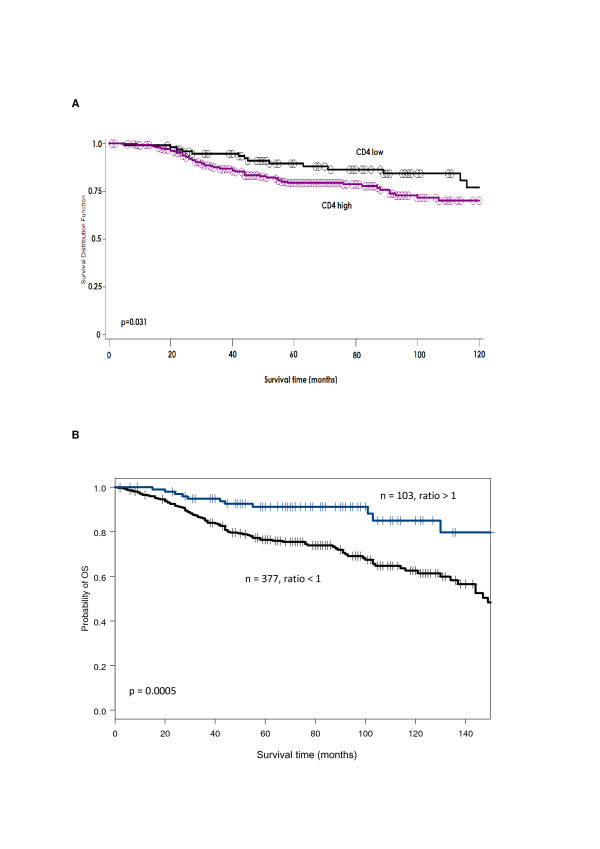
Overall survival analysis in patients with ductal breast cancer. A: Overall survival in patients with ductal carcinomas and high and low level of CD4+ TILs. Kaplan-Meier survival curves (univariate-analysis) of ductal breast cancers and overall survival in patients with high level of CD4+ versus low level of CD4+ cells infiltrating the tumor. CD4+ infiltrating cells: high level of CD4+ violet curve; low level of CD4+ black curve. Patients with high level of CD4+ cell infiltration show a significant (p = 0.031) worse survival (cut-off established by ROC curves: > 6 CD4+ TILs). B: Overall survival in patients with ductal carcinomas according to total FOXP3/CD4 ratio > or < 1. Kaplan-Meier survival curves (univariate-analysis) of ductal breast cancers and overall survival in patients with ratio of total FOXP3+/CD4+ cells > 1 (blue curve) or < 1 (black curve). Patients with a > 1 ratio had a significantly better survival (p = 0.0005).